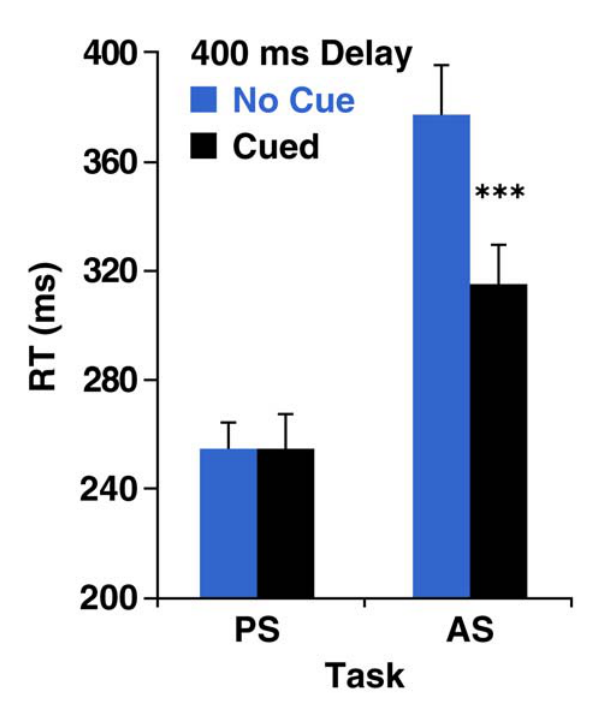
FIGURE 3. Response times, Experiment 1. Mean response times for Experiment 1 (400-ms delay only) on cued and no cue trials for prosaccade and antisaccade tasks. Cues facilitated antisaccades but not prosaccades. PS, prosaccade task; AS, antisaccade task.